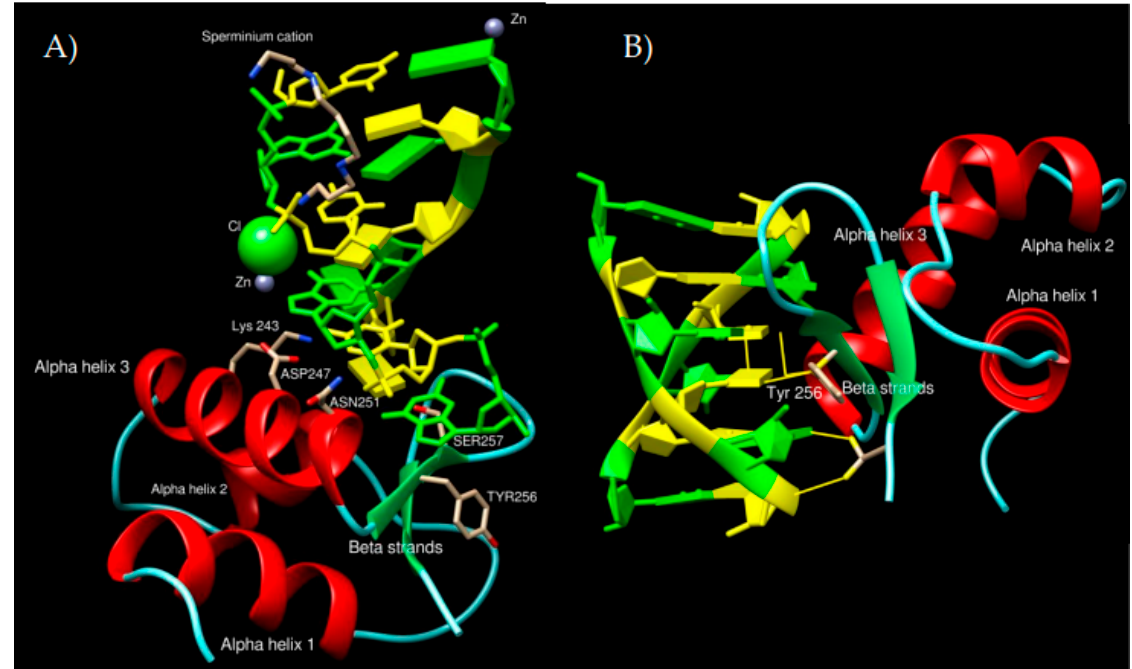
Figure 5. Representative molecular docking of human RPA2 Z α structural homolog to Z-DNA ( A ) and Z-RNA ( B ). Protein alpha helices are in red, beta-strands in green, coiled-coil regions in azure. Highlighting of Z-DNA/Z-RNA follows classic NDB colouring (guanines in green, cytosines in yellow).